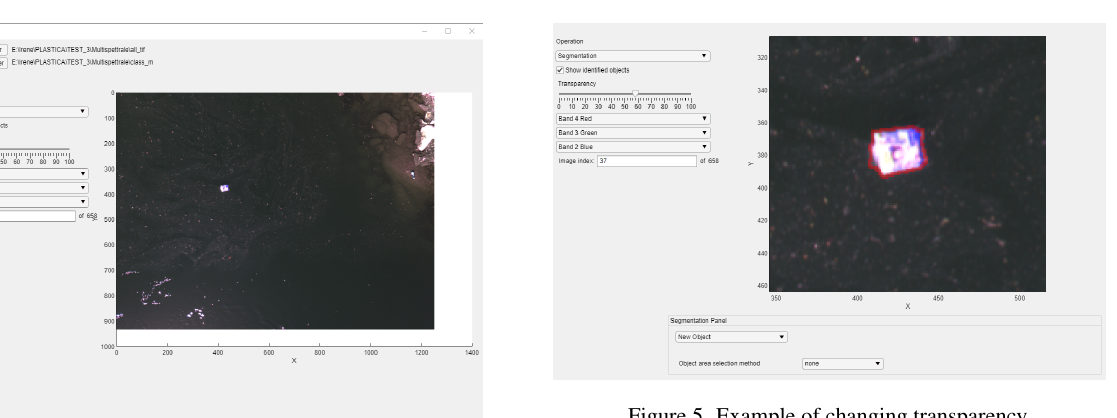
Figure 5. Example of changing transparency.